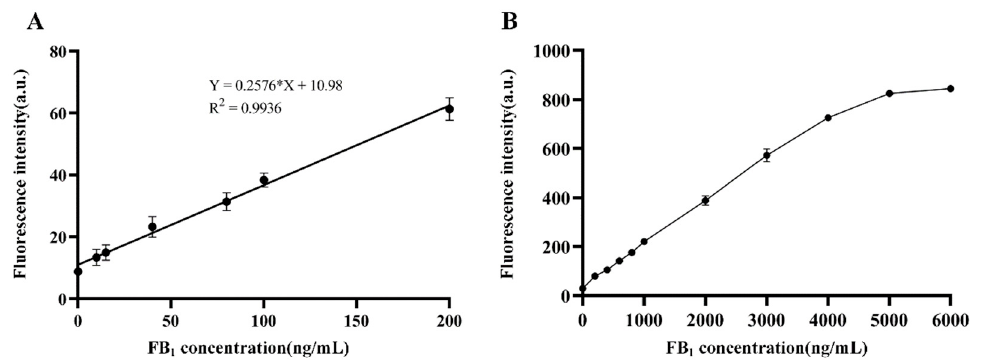
Figure 3. Sensitivity of the fluorescent aptasensor for FB 1 detection. ( A ) Linear relationship between the fluorescence and the FB 1 concentration (0, 10, 15, 40, 80, 100, and 200 ng/mL). ( B ) Detection range of the fluorescent aptasensor for FB 1 detection.